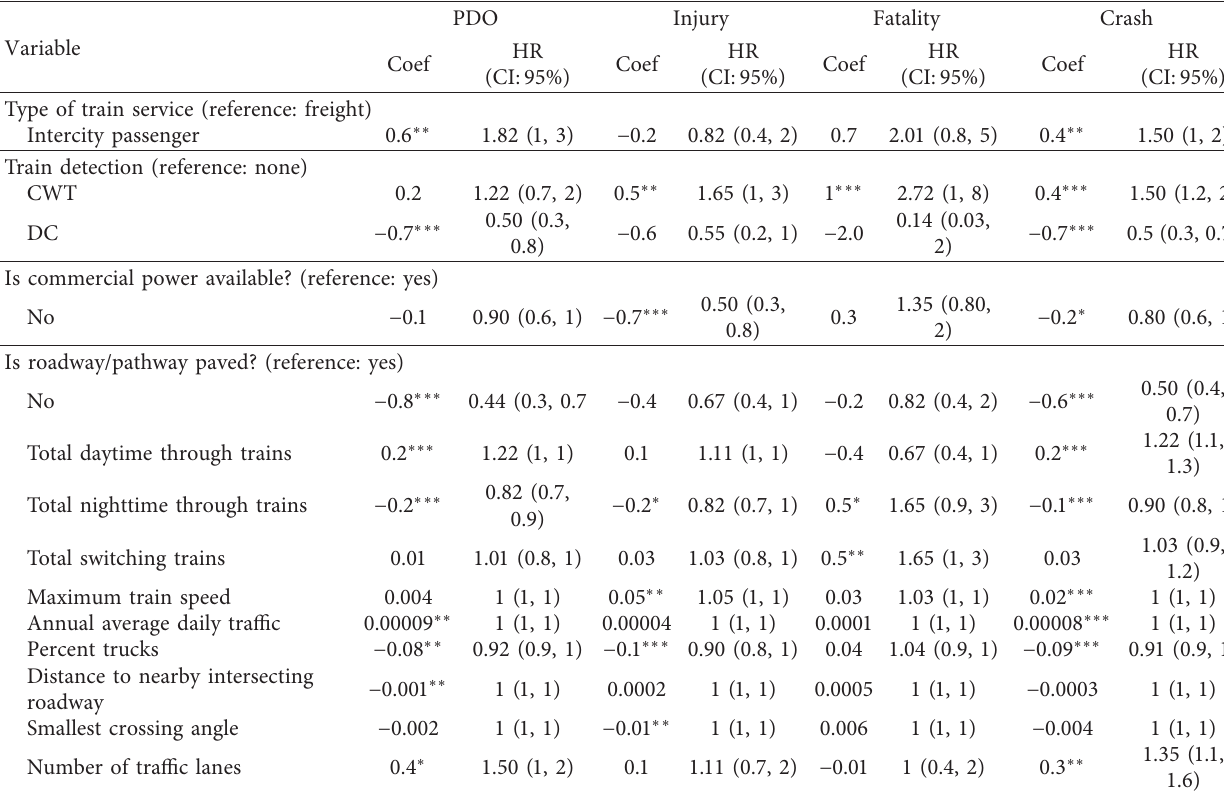
Table 2: Estimated coefficient and hazard